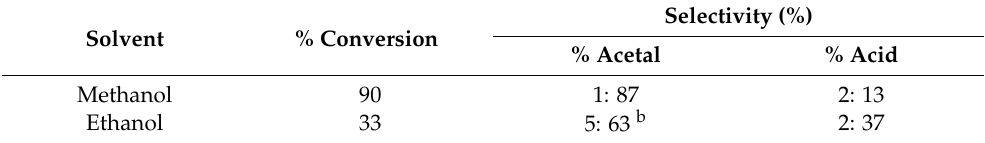
Table 8. Comparison between the same reaction conditions in methanol and in ethanol a .